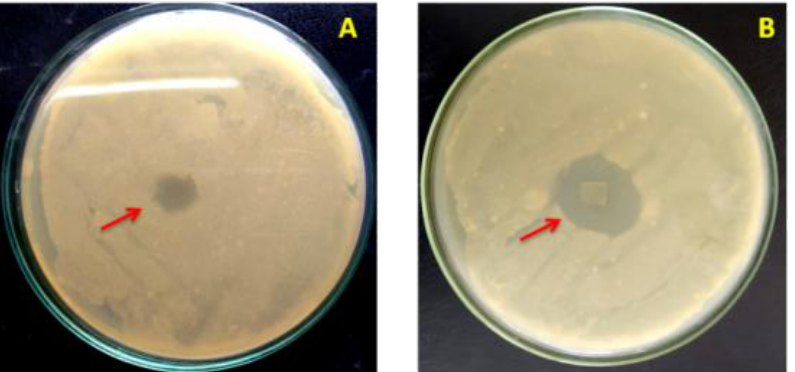
Figure 6. Antimicrobial activity of chitin film. ( A ) Chitin and starch mediated film. ( B ) Chitin, starch, and ascorbic acid mediated film.